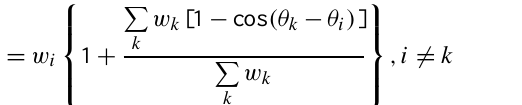
difference vegetation index (NDVI) and normalized differ- ence snow index (NDSI) were jointly used to discriminate snow-free and snow covered forests, using the algorithm of Klein et al. (1998). All MODIS datasets were acquired from the NASA Earth Observing System Data and Infor- mation System (EOSDIS) ( http://reverb.echo.nasa.gov), and processed by the MODIS Reprojection Tool (MRT,